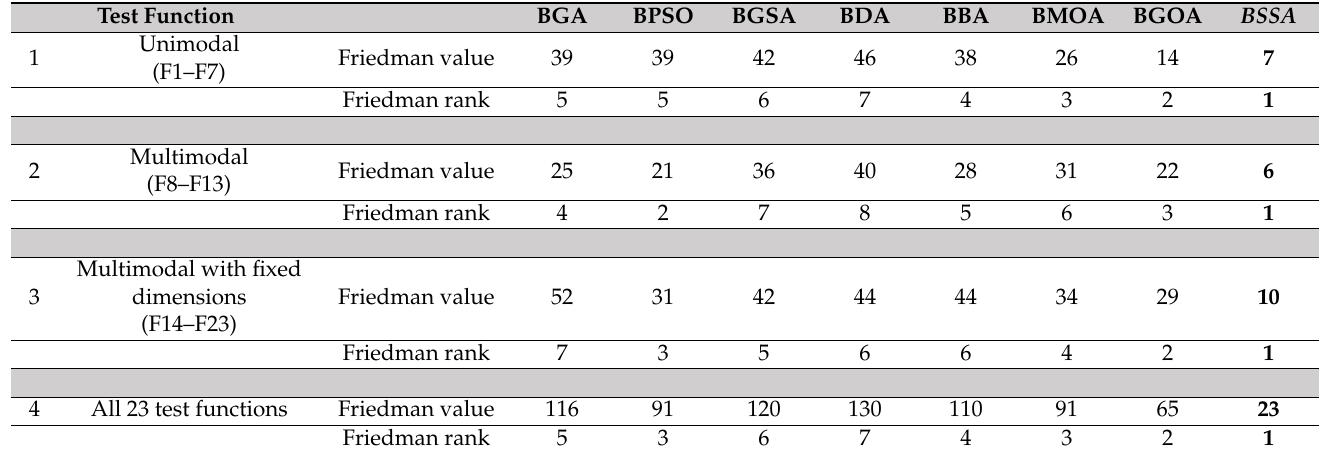
Table 8. Results of the Friedman rank